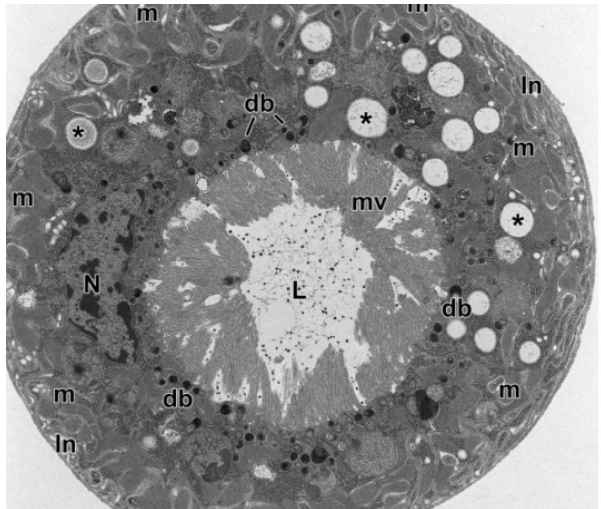
Figure 1. Cross-section through a Malpighian Tubule (MT) of an Aeolothrips intermedius Bagnall, 1934 (Thysanoptera: Aeolothripidae) adult. The epithelial cells show a basal system of membrane infoldings with associated mitochondria. The nucleus occupies the central cell region. In the cytoplasm, there are numerous electron-transparent inclusions, sometimes with concentric layers (asterisks). Electron-dense bodies are visible at the apex of epithelial cells, at the base of microvilli. In the MT lumen are present scattered small electron-dense granules. db = electron-dense bodies, In = membrane infoldings, L = lumen, m = mitochondria, mv = microvilli, N = nucleus. From Conti et al. [5].